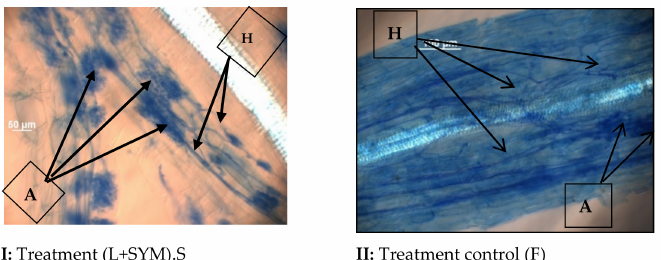
Figure 1. ( I ): Sweet potato seedlings treated with mycorrhizal inoculum in a sterilized form with the hyphal (H) and the arbuscular development (A). ( II ): Dense arbuscular formation in control sweet potato seedlings. Arbuscular mycorrhiza could also develop in both varieties when they were treated with soil from the experimental and research farm (F). The hyphal development (H) and the arbuscular establishment (A) can also be observed.